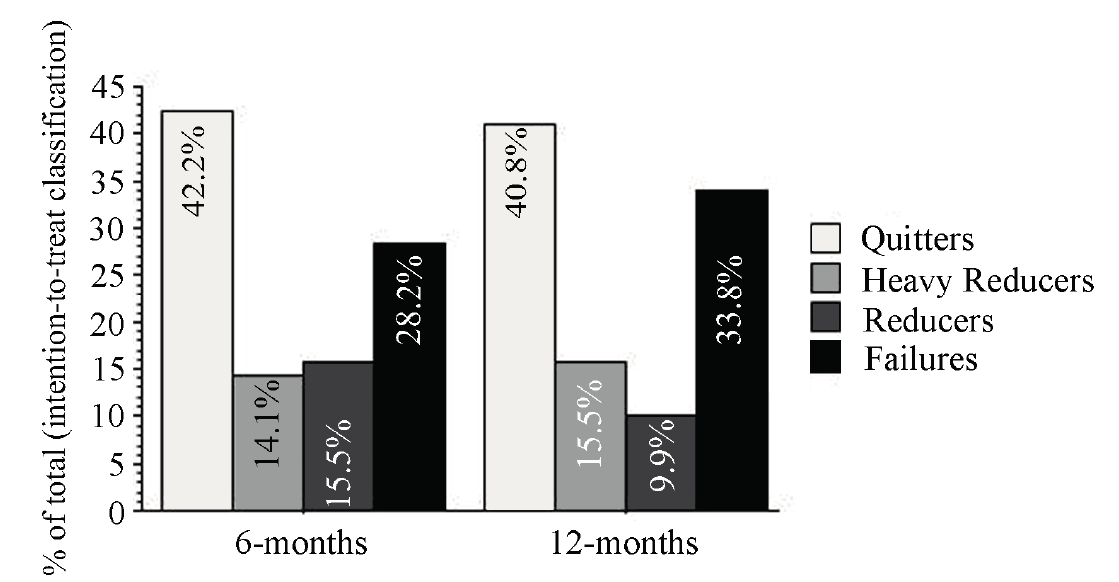
Figure 1. Distribution of smoking phenotype classification (intention-to-treat analysis) at 6 and 12 month follow-up